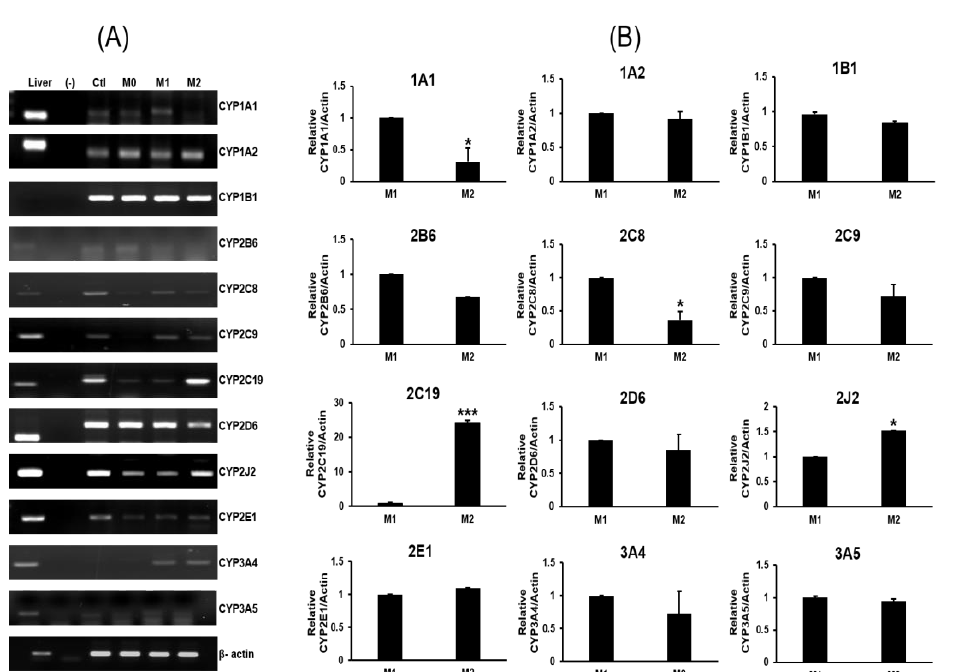
Figure 2. Expression profiles of CYP genes in THP-1 monocytes and M0, M1, and M2 macrophages. ( A ) RT-PCR analysis of CYP expression. RT-PCR was used to amplify the mRNA of each CYP using gene-specific primers as described in the Materials and Methods. Data represent three independent RT-PCR assays. Each target CYP was amplified as a single band with the same size as that found in liver cDNA, which was used as a positive control. No bands were detected in PCR reactions that lacked reverse transcriptase, which confirmed the absence of genomic DNA contamination. ( B ) Quantitative values were determined from three independent experiments using ImageJ software. Values are presented as the mean ± standard deviation relative to β-actin ( n = 3). * p < 0.05, *** p < 0.001.